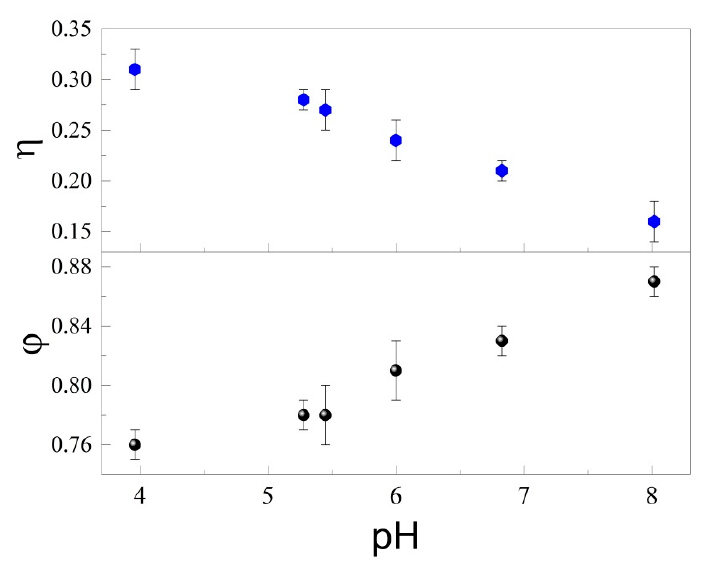
Figure 4. The number of rings (N) as a function of excitation beam power ( P e ) for pigment that was extracted from the plant in aqueous solutions ( α = 3.3 cm − 1 , pH 5.2, and λ = 514.5 nm). Inset: N versus P e ; the linear trend was obtained by fitting with the slopes of (17.8 ± 0.5) W − 1 (L = 2 mm).